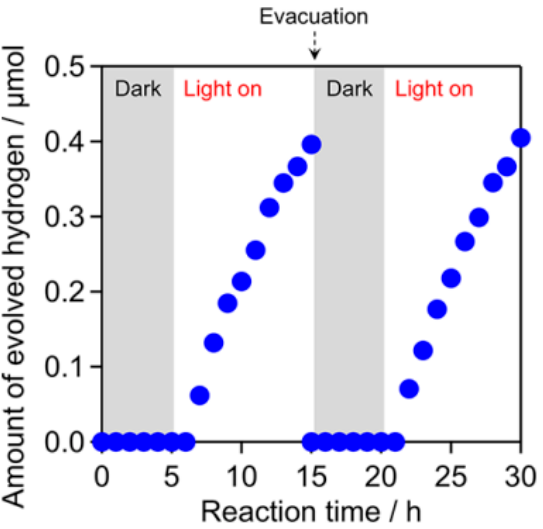
Figure 10. H 2 evolution over Pt/Rb 2 NdNb 2 O 6 N in DMSO/TEOA solution containing 1 mL of water. Reprinted with permission from the authors of [59]. Copyright (2019) American Chemical Society, Washington, DC, USA.